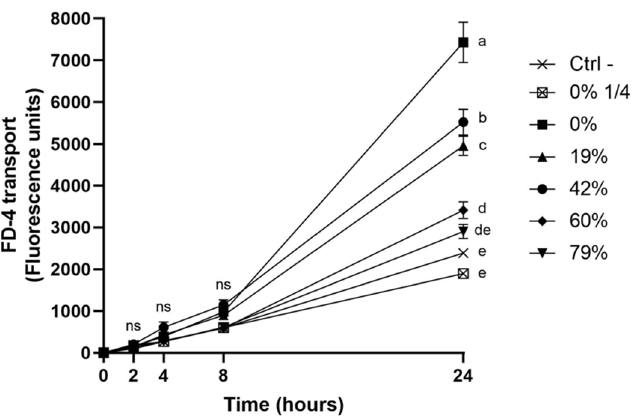
Figure 5. Time-dependent paracellular transport of FD-4 across a B11 keratinocyte monolayer exposed (5 min) to raw or deacidified (0, 19, 42, 60, and 79%) cranberry juice. FD-4 was added to the apical compartment, and the fluorescence of the basolateral compartment is reported. Results are expressed as means ± SD of triplicate assays from a representative experiment. Treatments with different letters are significantly different from one another (Two-way ANOVA, Bonferroni test, p < 0.01).